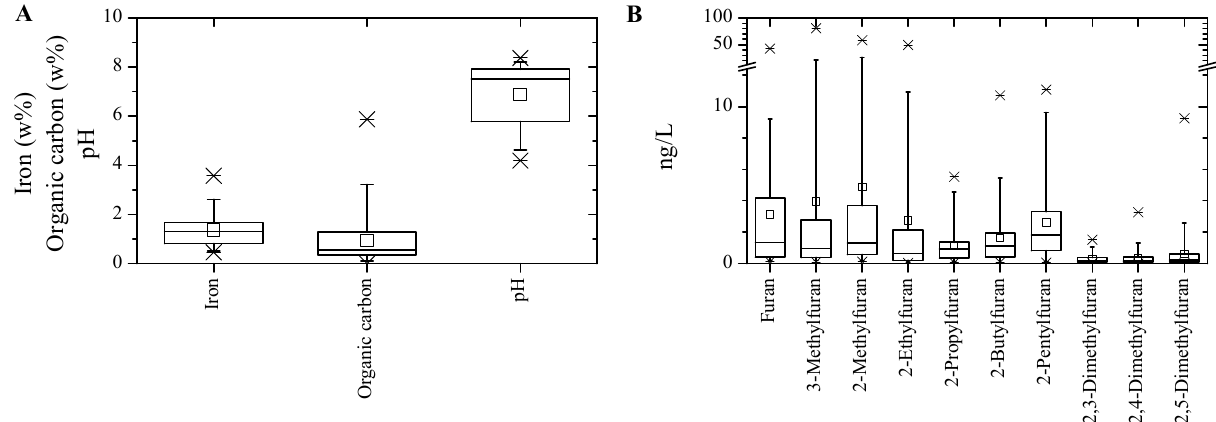
Figure 4. Distribution of (A) iron and organic carbon concentration as well as pH and (B) of the furan emissions from the various Australian and Dead Sea sediment samples.